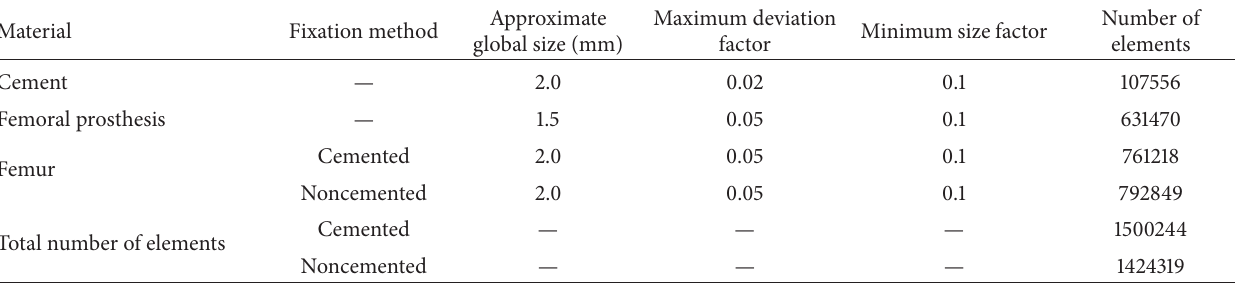
Table 1: Some features of the finite element mesh.